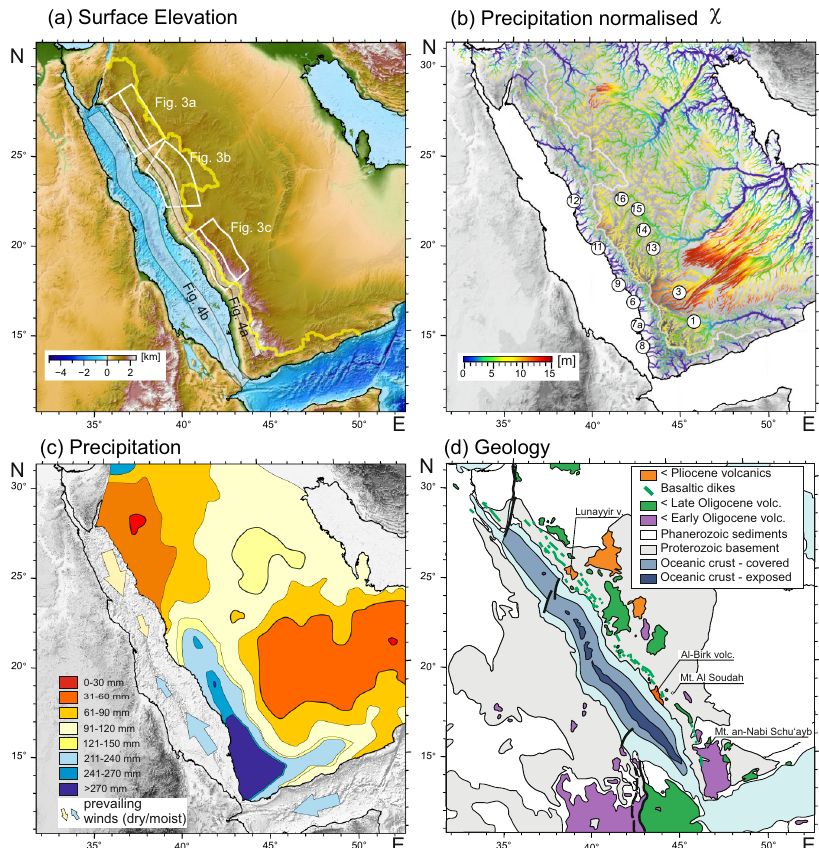
Fig. 1 | Major features of the Saudi Arabian margin. a Topography also showing the continental divide (yellow line) and the position of the curved swath pro fi les shown in Figs. 3 and 4 (white boxes and shaded region along Red Sea center). b χ 17 map normalized for precipitation (method 35 , precipitation data 24 , DEM data 36 .